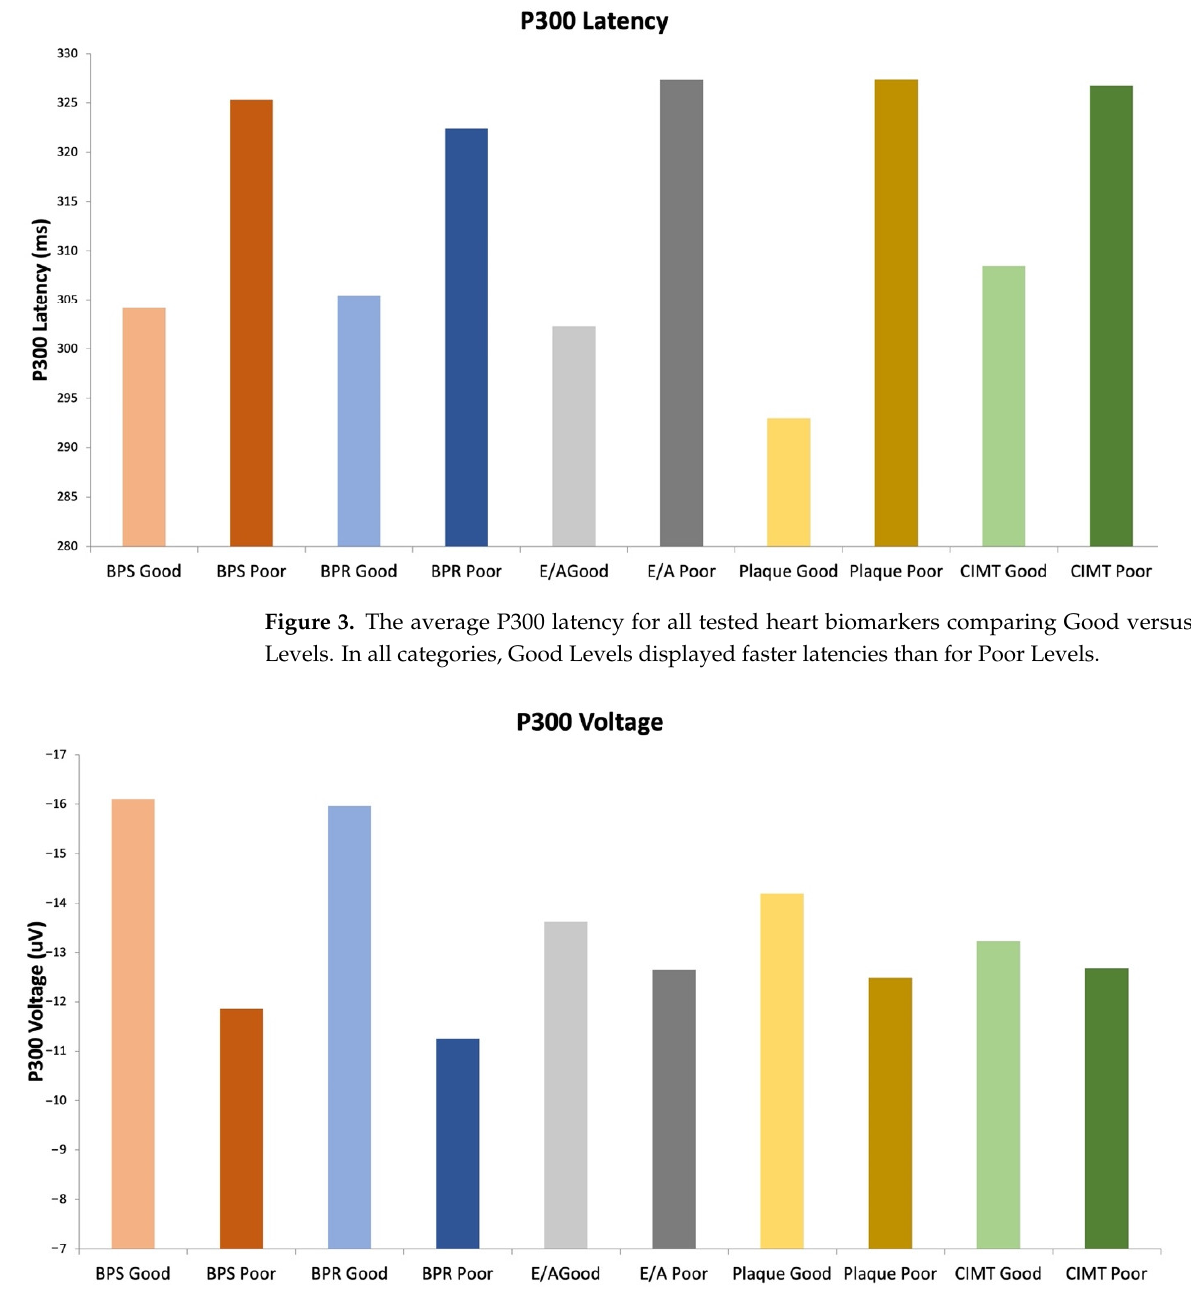
Figure 4. The average P300 amplitude for all tested heart biomarkers comparing Good versus Poor Levels. In all categories, Good Levels displayed larger amplitudes than for Poor Levels.